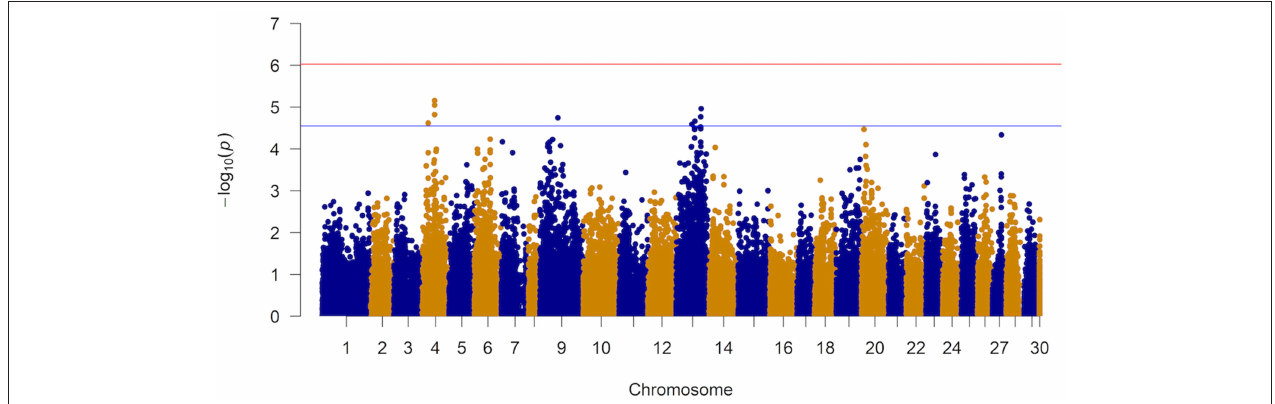
FIGURE 4 | Manhattan plot from the genome-wide marker analysis of resistance to AGD. The red and blue represent Bonferroni and chromosome-wide significance thresholds.